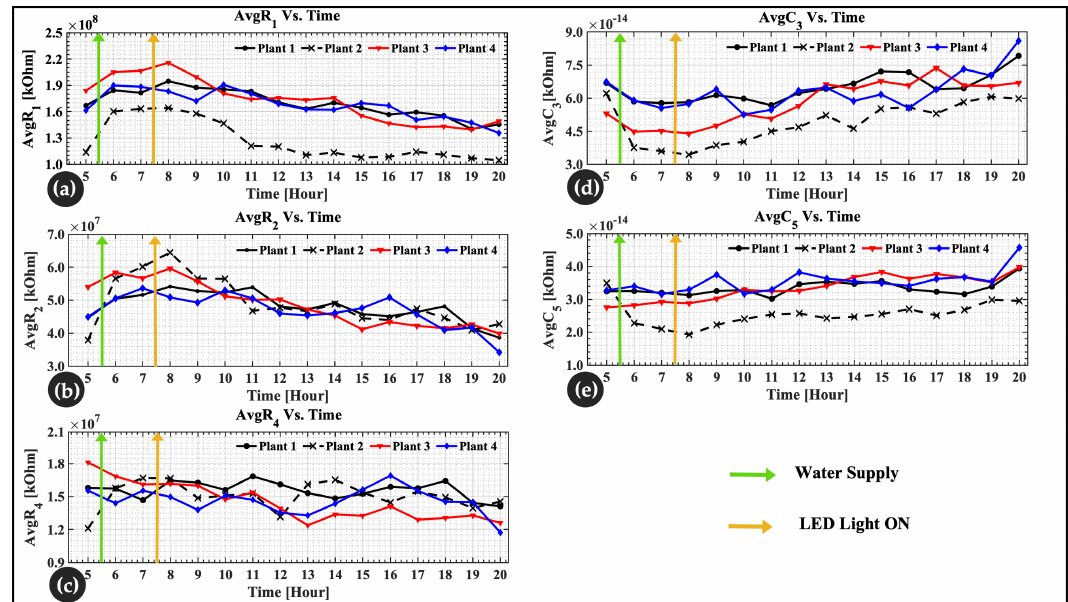
Figure 10. Changes in the inner cell’s physiology over time. ( a ) ECF and cell wall resistance; ( b ) cytoplasmic resistance; ( c ) vacuole resistance; ( d ) cell membrane capacitance; ( e ) vacuolar mem- brane capacitance.